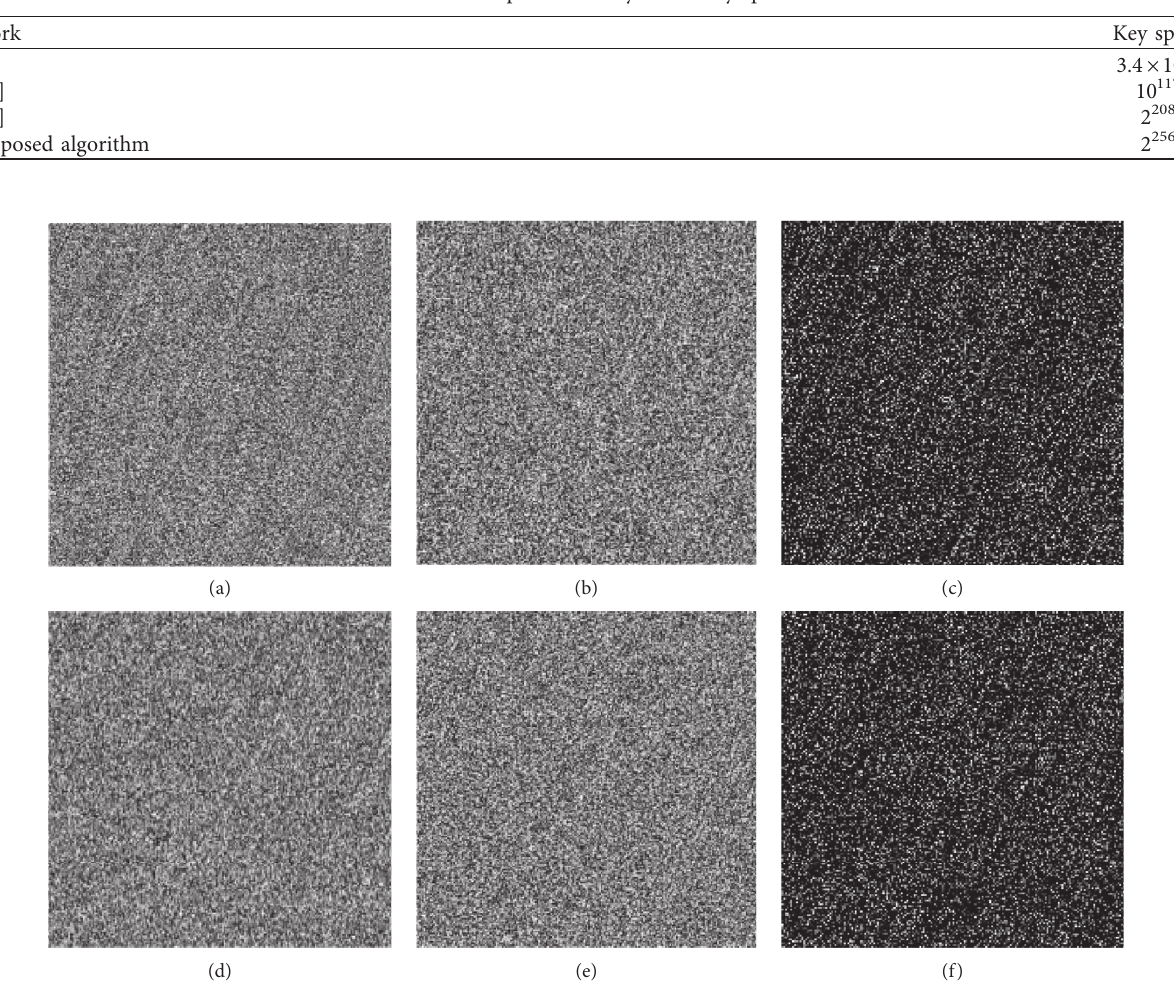
Table 6: Comparative study of the key space.